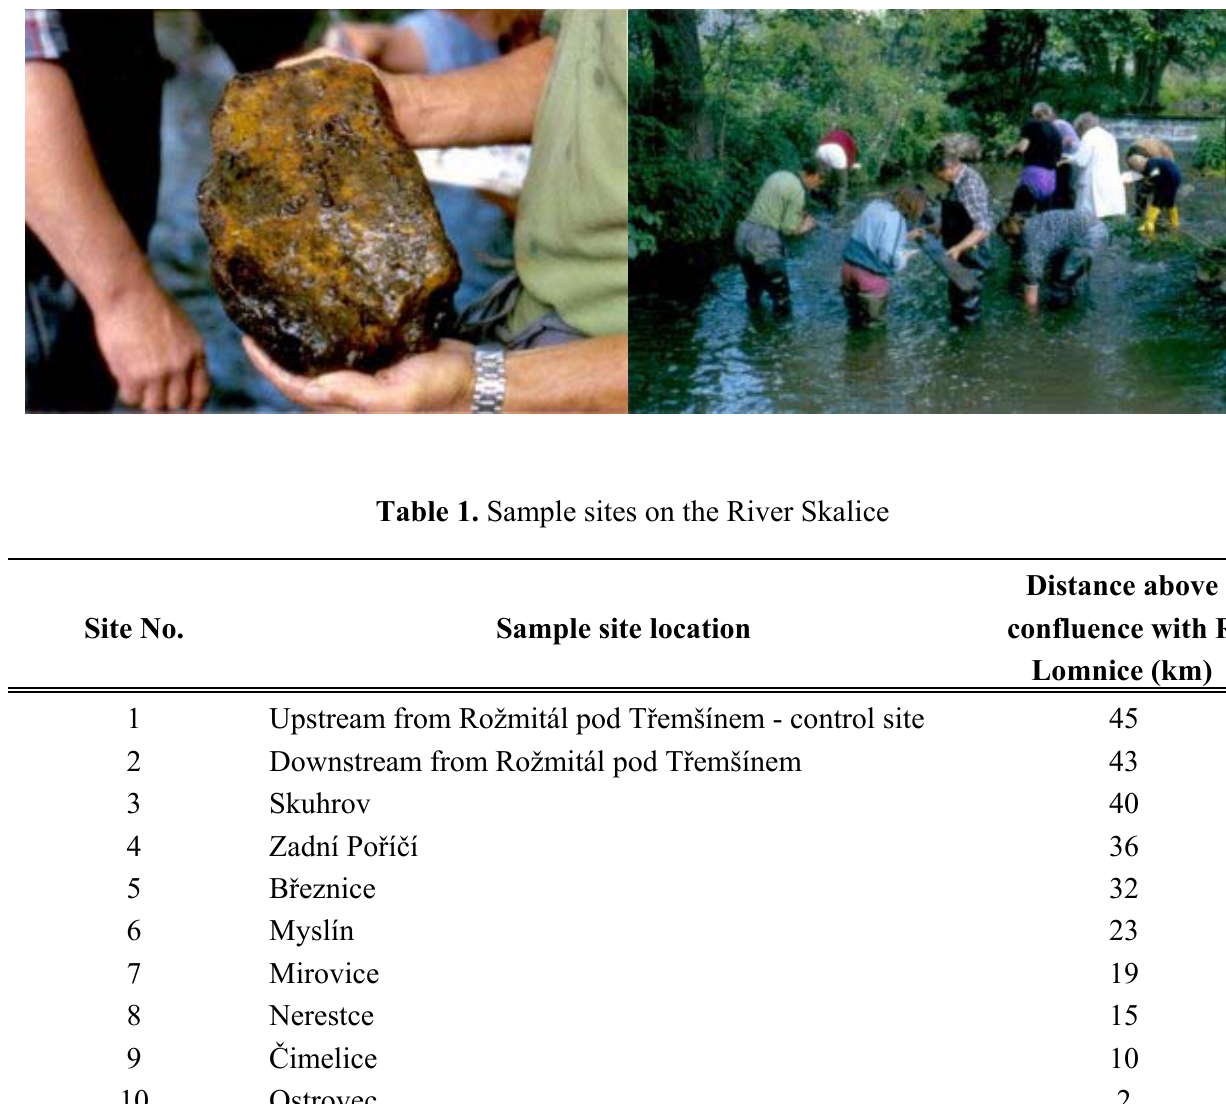
Figure 3. Collection of leeches in the Skalice River.